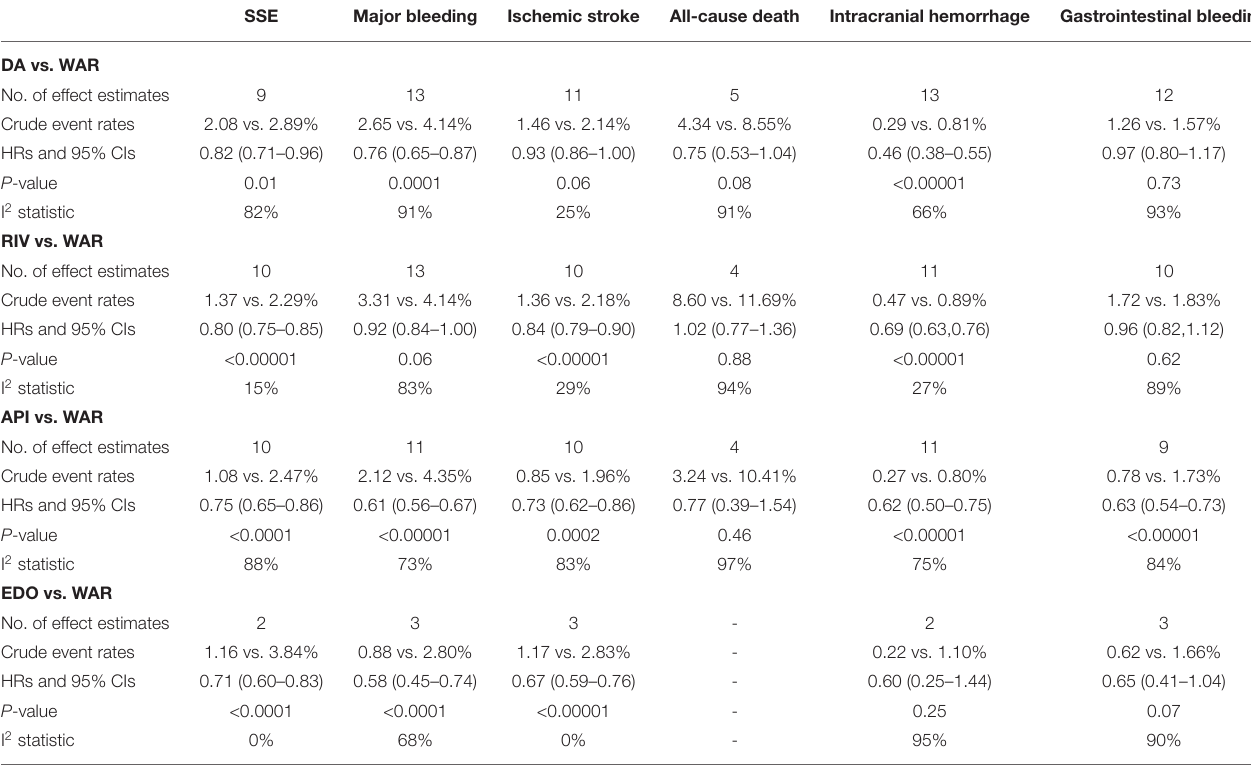
TABLE 2 | Pooled HRs of the effectiveness and safety outcomes between NOACs vs. warfarin in patients with AF. SSE Major bleeding Ischemic stroke All-cause death Intracranial hemorrhage Gastrointestinal